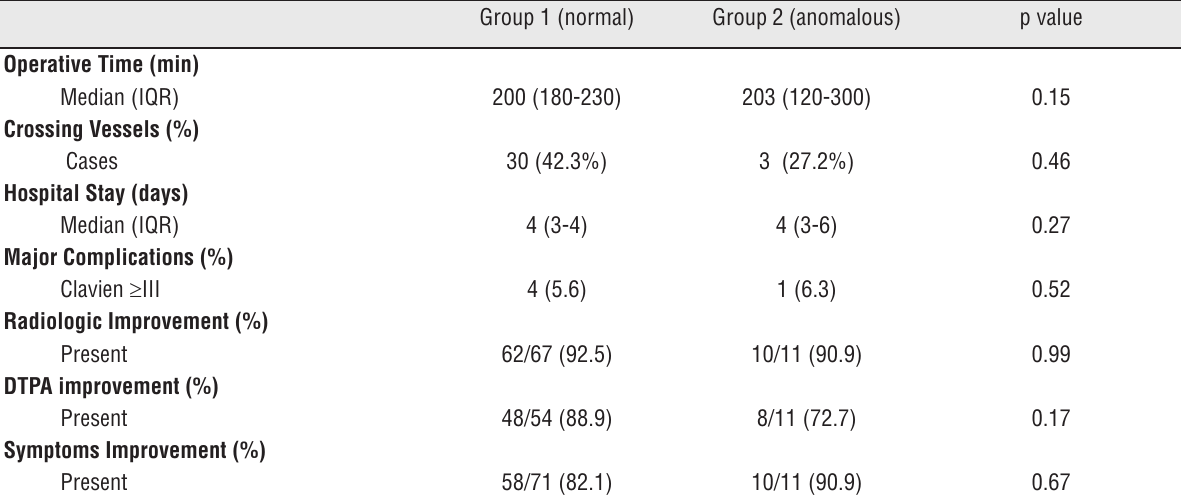
Table 1C - Operative Time, crossing vessels, hospital stay, complications, clinical and radiologic